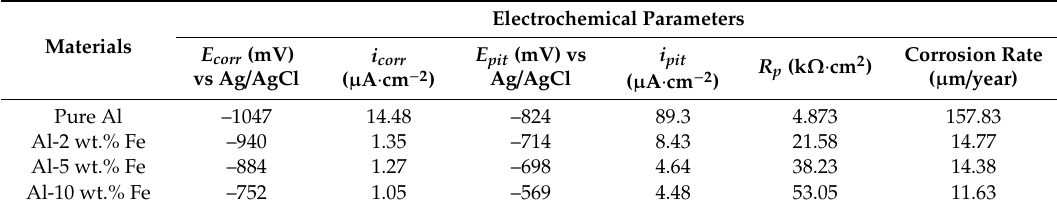
Figure 7. Cyclic-polarization (CP) curves for pure Al and Al-Fe alloys after one hour immersion in 3.5% NaCl solution. Table 2. Electrochemical parameters obtained after fitting CP graphs in Tafel regions for pure Al and Al-Fe alloys after one hour immersion in 3.5% NaCl solution.